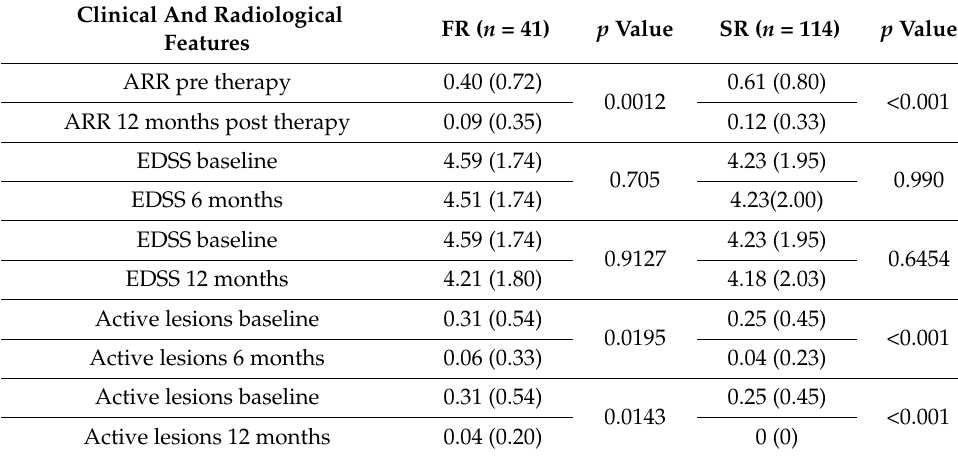
Table 3. Ocrelizumab effectiveness in patients with fast and slow repopulation rate at six months. Data are reported using mean ± standard deviation (sd).